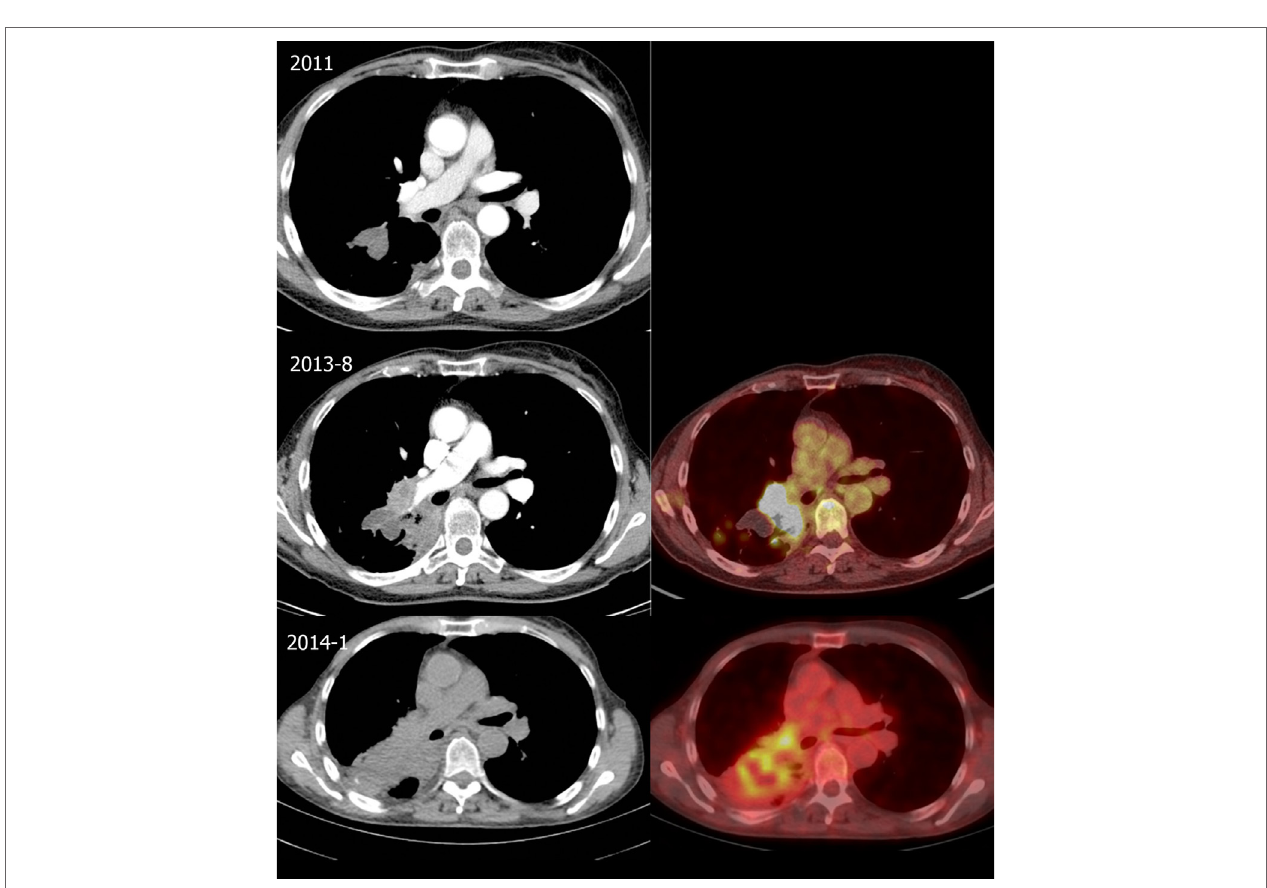
FIGURe 1 | Timeline. Abbreviations: 18 FDG, 18-fluordeoxyglucose; CT, computed tomography; VATS, video assisted thoracic surgery; 18 FDG-PET-CT, 18-fluordeoxyglucose positron emission tomography-computed tomography; EBUS-TBNA, endobronchial ultrasound with transbronchial needle aspiration; MRI, magnetic resonance